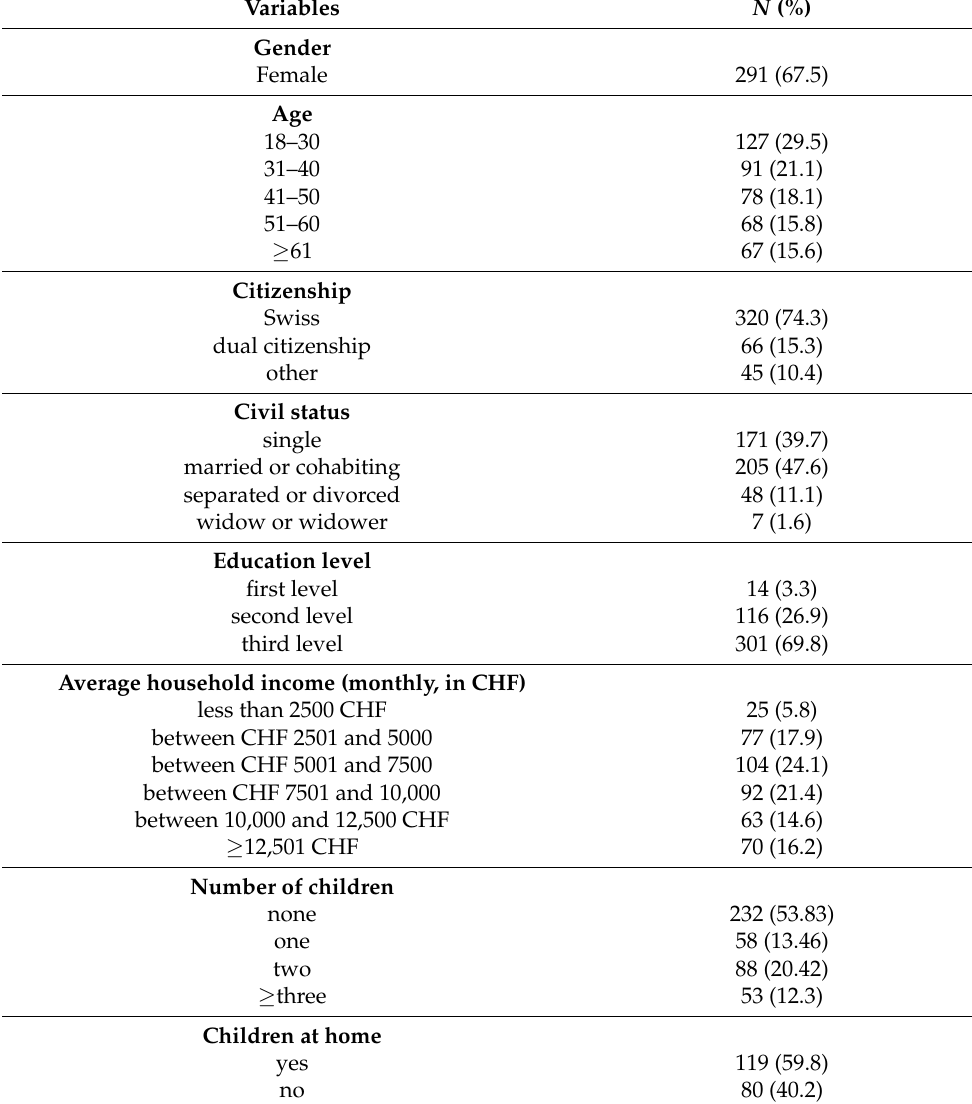
Table 1. Sociodemographic characteristics of the studied population.